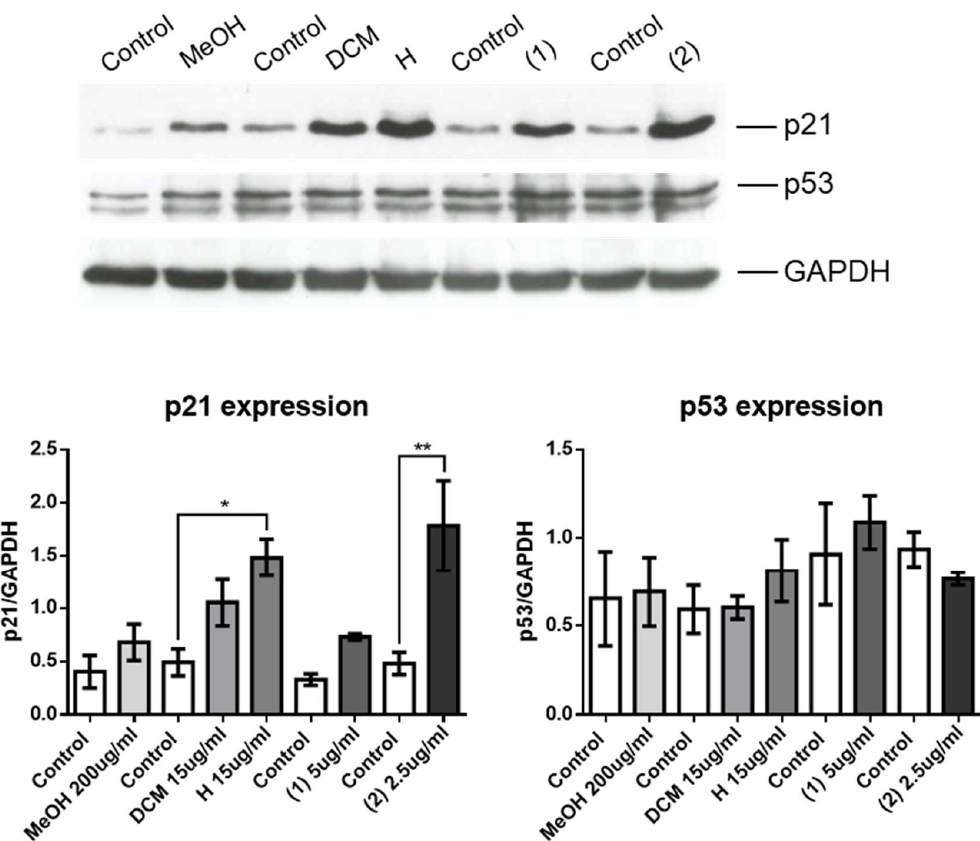
Figure 6. Effects of extracts and compounds on expression of proteins involved in the cell cycle. Upper panel, western blot analysis illustrating expression of p21, p53 and GAPDH using cell lysates extracted from OCI-AML3 cells treated with vehicle (Control), M (MeOH), DCM (DCM), H (H) extracts and compound 1 (1) or 2 (2) for 24 h. Western blots are representative of three independent experiments. Lower panels, Quantification of experiments shown in upper panel with the indication of the concentration used. Data from three independent experiments are reported as mean ± SEM. * p < 0.05, ** p < 0.01.